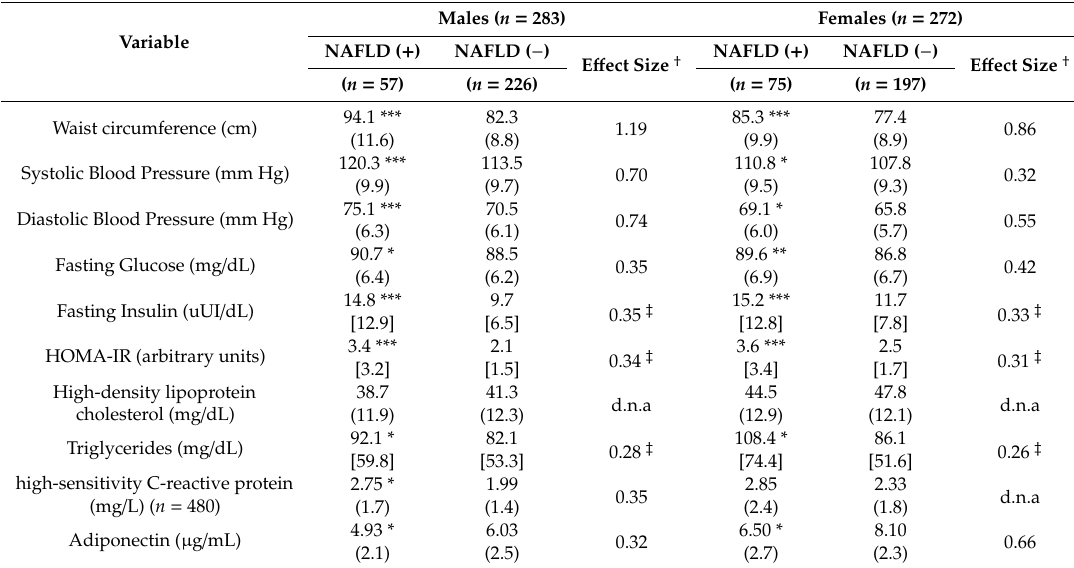
Figure 3. Cardiometabolic risk at 23y in the Santiago Longitudinal Study by NAFLD diagnosis with abdominal ultrasound: male ( a ) and female ( b ) participants Metabolic Syndrome and its components were diagnosed with the AHA / NHLBI / IDF joint standard. Insulin resistance was diagnosed with HOMA-IR values ≥ 2.6 in both male and female participants. Chi2 test for independence: * p < 0.05, ** p < 0.01, *** p < 0.001. Table 4. Cardiometabolic profile at 23y in male and female SLS participants with and without non-alcoholic fatty liver disease (NAFLD), according to abdominal ultrasound (NAFLD ( + ) or Hamaguchi score ≥ 4) ( n = 555).